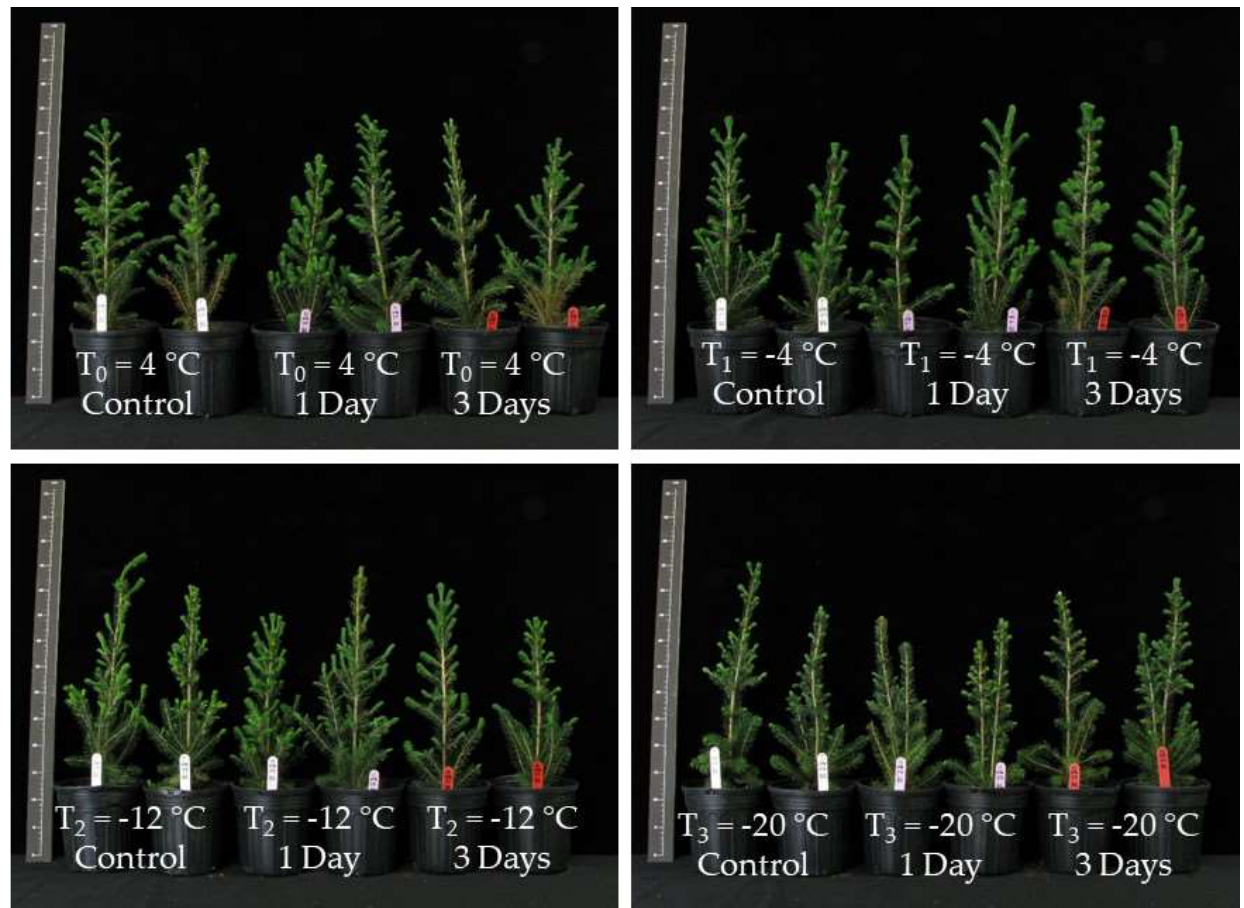
Figure 7. Normal bud break of the apical buds and lateral branches of white spruce seedlings (2 + 0) in response to their exposure to the three treatments (Control at 4 °C in the dark, 1 day at 10 °C and 3 days at 10 °C under the natural photoperiod of the season) and followed by artificial freezing temperatures (−4 °C, −12 °C and −20 °C) at the beginning of winter (mid-January).